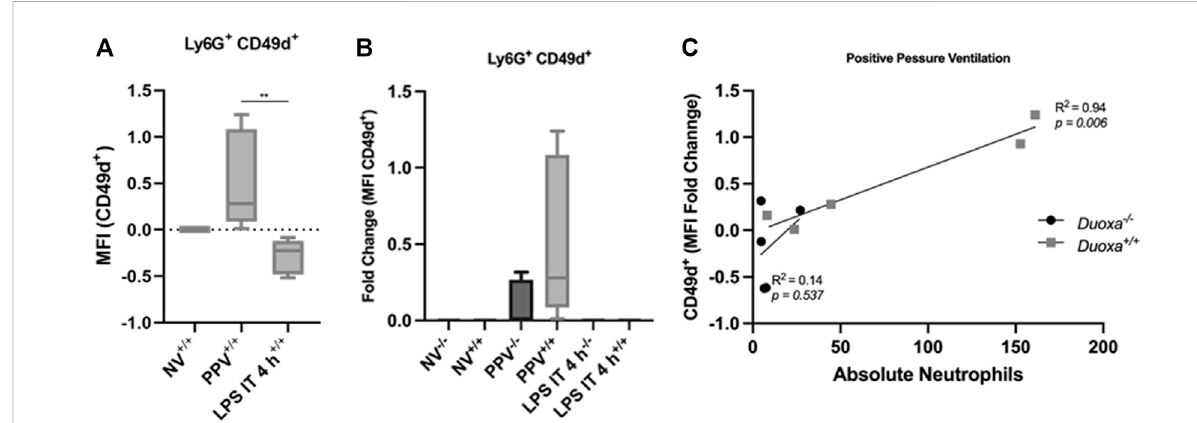
FIGURE 4 Injurious positive pressure ventilation induces CD18-independent mechanisms that is Duox-dependent. Duoxa knockout mice ( − / − ) and wild- type mice (+/+) were subjected to injurious positive pressure ventilation (PPV) or instilled intratracheally with lipopolysaccharide (LPS) followed by isolation of neutrophils from bronchoalveolar lavage (BAL) by fl ow cytometry using Ly6G antibody and subsequently phenotyped using CD49d antibodies. (A) Mean fl uorescence intensity (MFI) of BAL neutrophils gated for Ly6G + and CD49b by fl ow cytometry isolated from wild-type (+/+) mice in non-ventilated, untreated (NV) controls compared to PPV- and LPS-exposed mice. (**, p = .005). (B) Fold change of MFI for Ly6G + , CD49d + neutrophilsisolatedfromBAL fl uidinnon-ventilated,untreatedwild-type(+/+)andDuoxaknockout( − / − )micecomparedtoPPV-andLPS- treatedmice.CD49d + expressionwashigherinwild-typeversusknockoutmiceonlyinthePPVgroup( p=.0079 ). (C) MFIofLy6G + CD49d + cellswas correlated to absolute neutrophils in bronchoalveolar lavage in mice exposed to PPV. There was a strong correlation seen in wild-type mice ( R 2 = 0.94, p = .006 ) that was not observed in Duoxa knockout